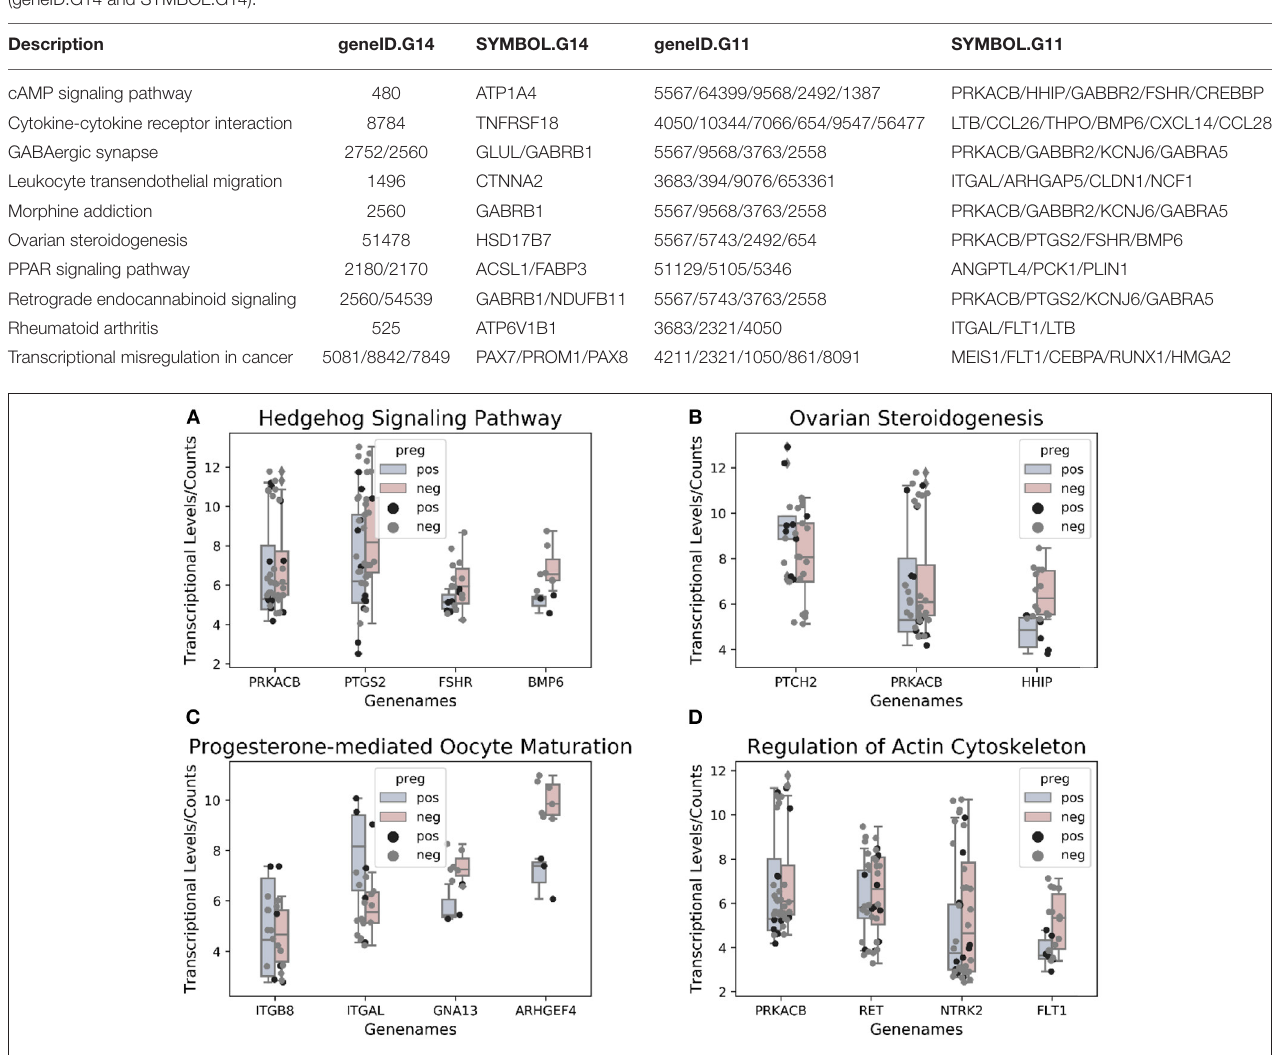
FIGURE 6 | (A–D) Genes associated with pathways overlapping between methylation and transcriptional